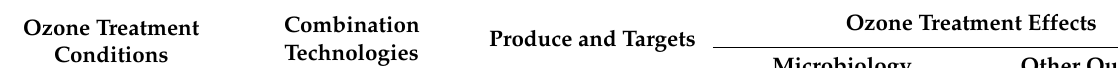
Table 6. Overview of ozone in combination with other